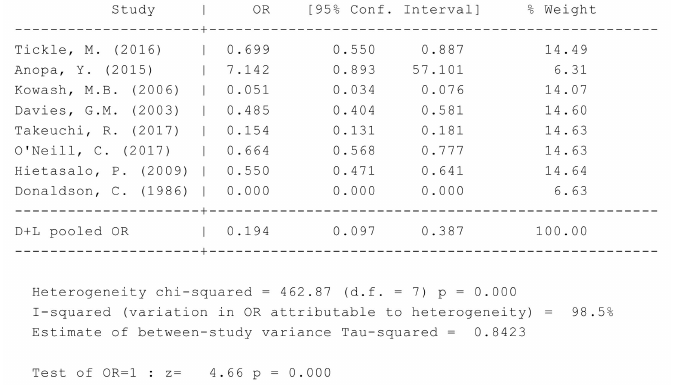
Figure A1. STATA do-files for analysis of Figure 2. “metan DMFTintervention NIntervention, DMFTcontrol Ncontrol, label (namevar = Author, yearvar = year) random or” .